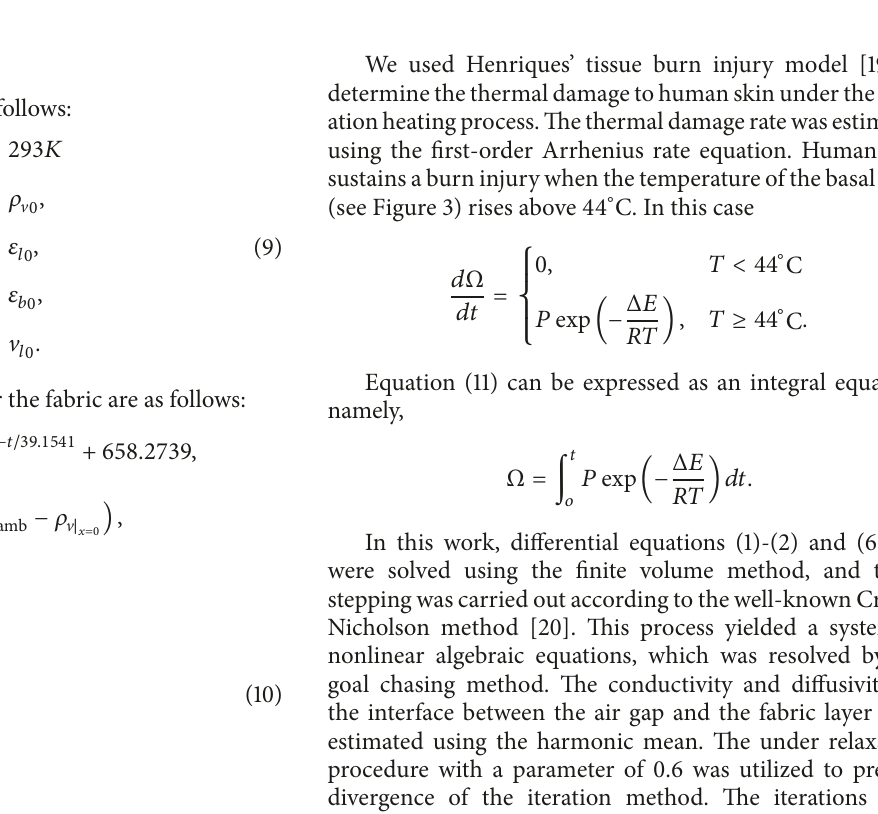
Figure 4: Temperature distributions for time and grid independence